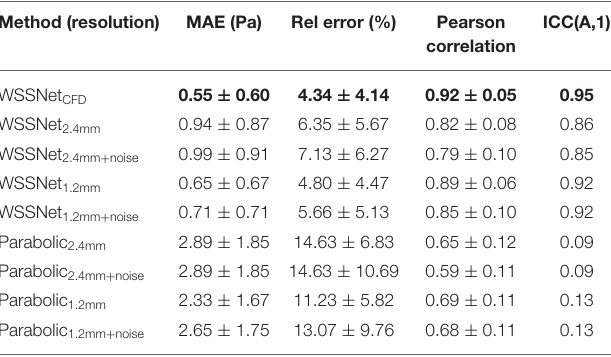
TABLE 2 | WSS magnitude and pattern similarity measurements for the validation and test cases of the CFD